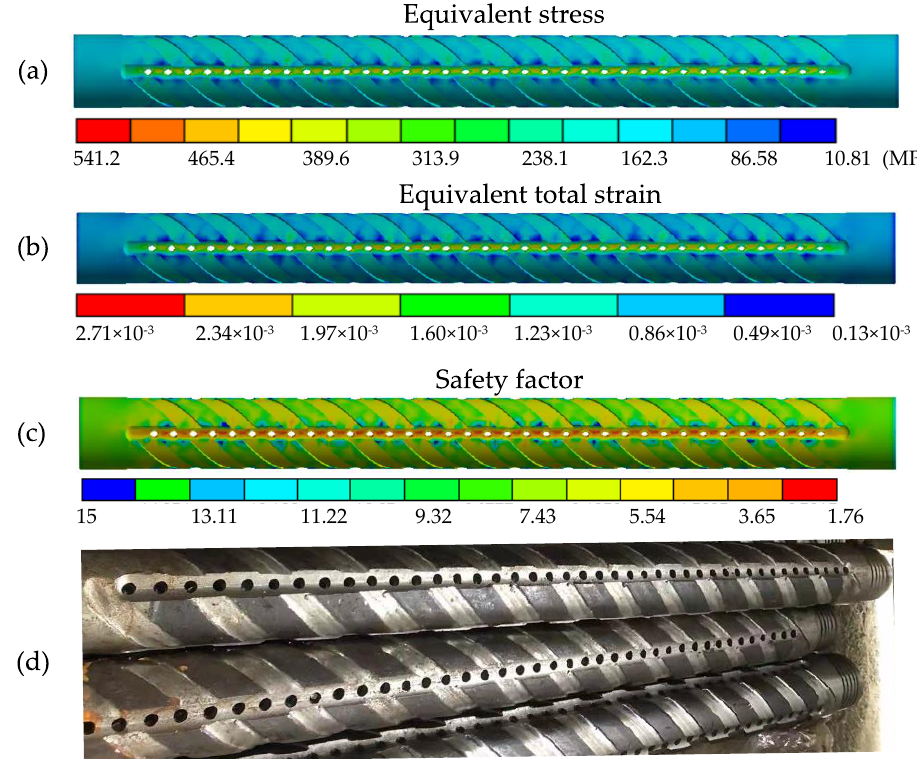
Figure 19. Strength simulation analysis and trial−manufacture of SMH drill pipe. ( a ) Equivalent stress; ( b ) equivalent total strain; ( c ) safety factor; ( d ) SMH drill pipe trial−manufactured .